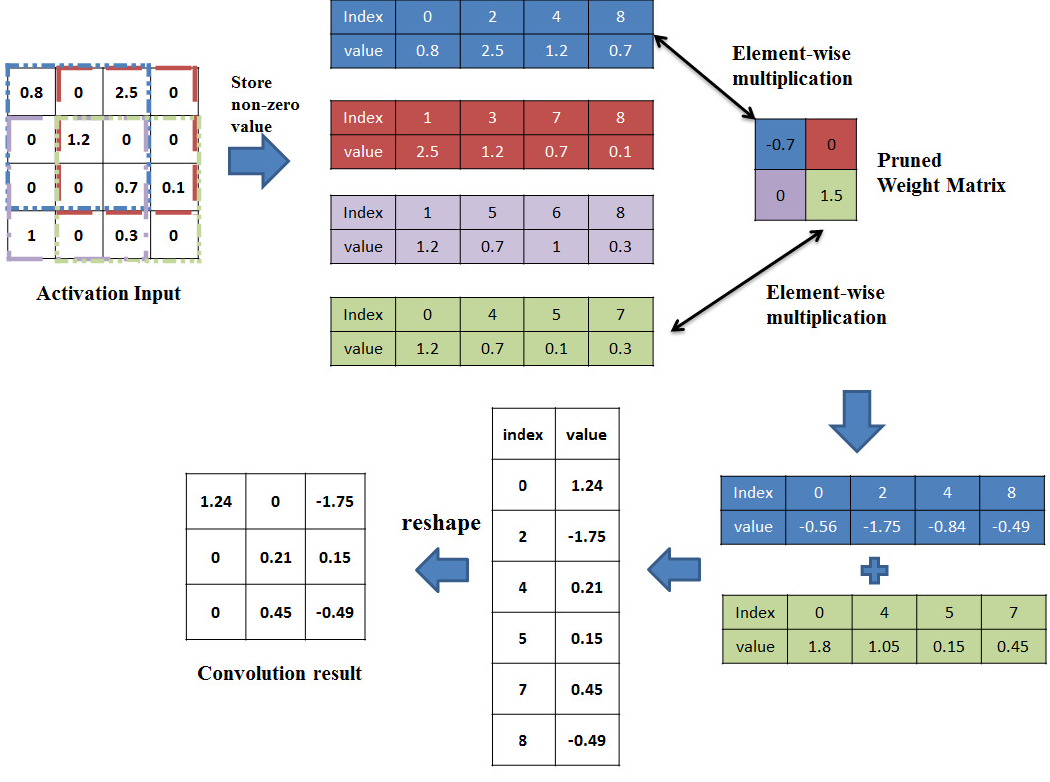
Figure 4. Fast algorithm for pruned convolutional